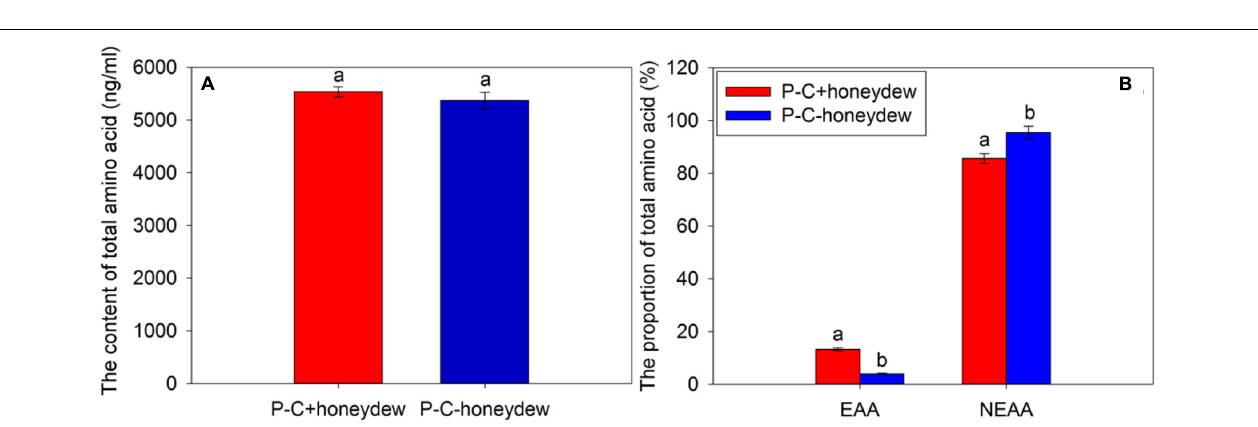
FIGURE 4 | The species of FAAs in the ACP adults feeding on C Las-infected and C Las-free citrus plants. “P+” and “P–” represent C Las positive and negative psyllids, respectively, and “C+” and “C–” represent C Las-infected and C Las-free citrus plants, respectively. Values are represented as mean ± SE, and ∗ over the bars means significant differences between groups at P < 0.05.